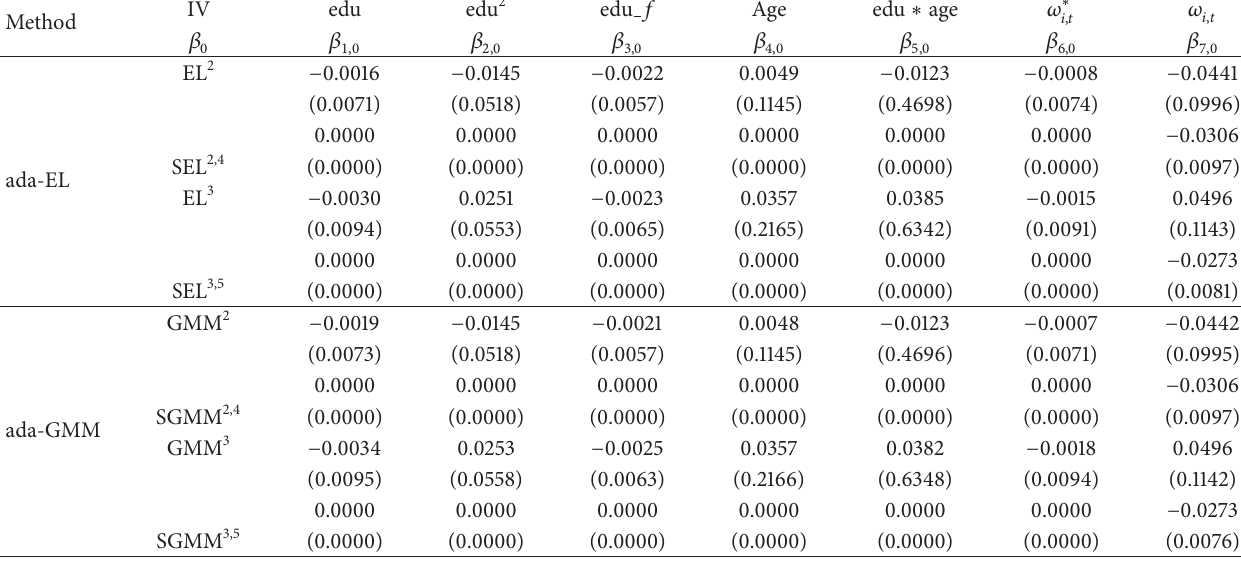
Table 3: EL and GMM shrinkage estimators of the moment selection coefficients 1